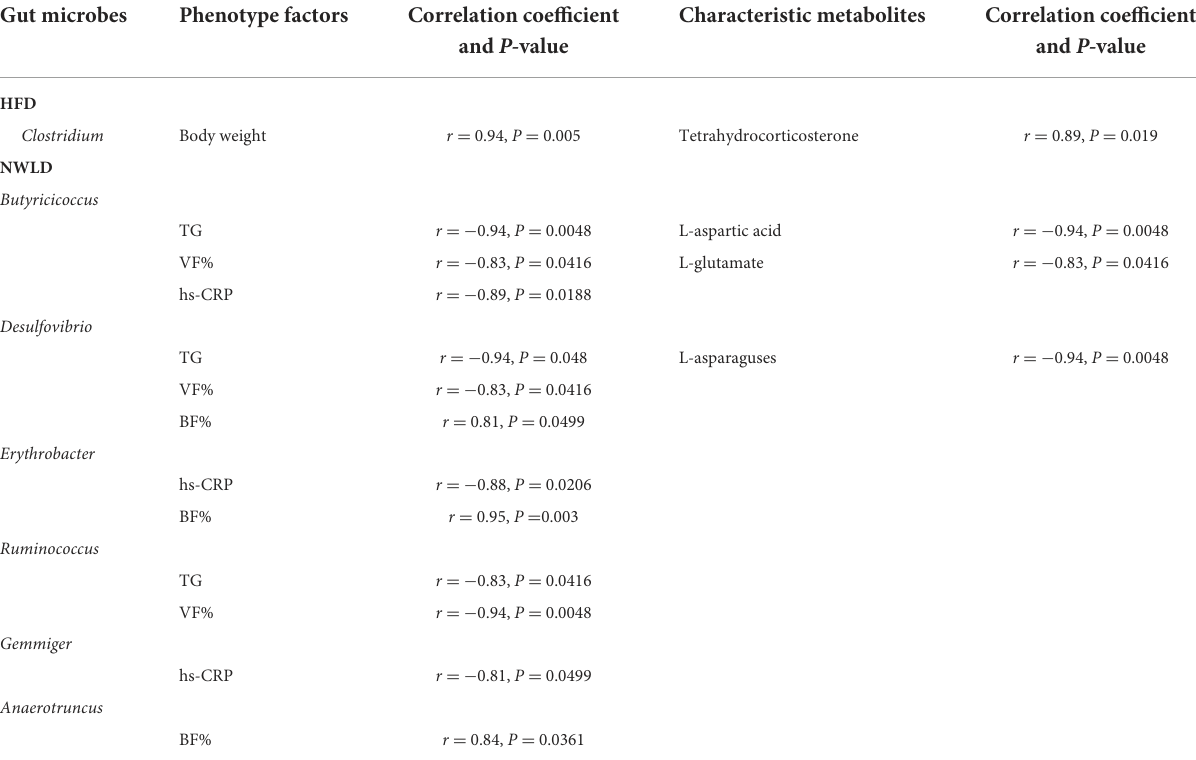
TABLE 5 Result of Correlation Network Analysis among relative frequency of gut microbes, phenotype factors, and characteristic